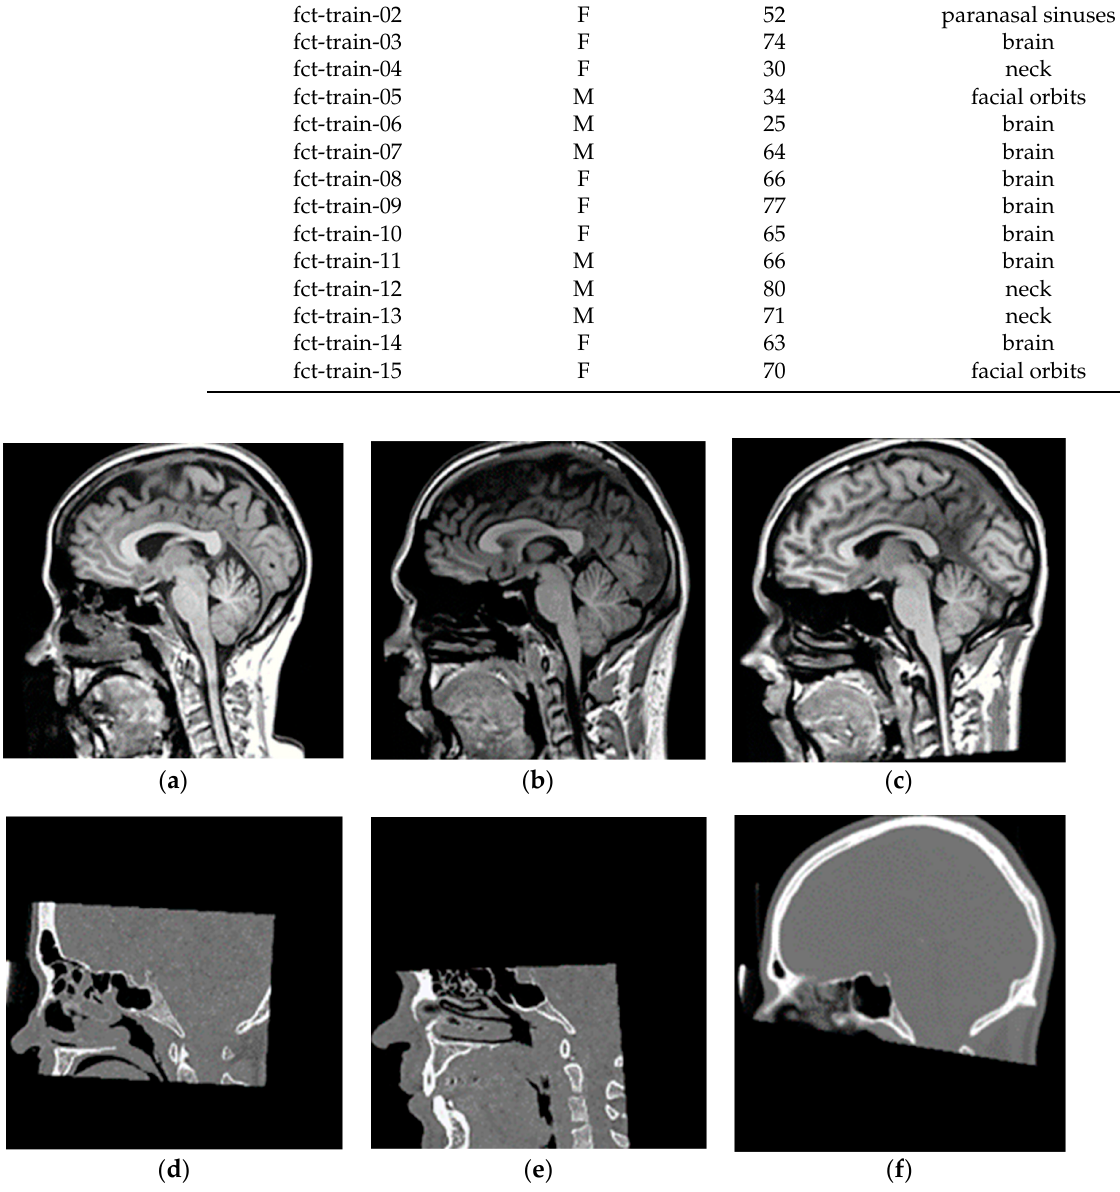
Figure 2. Representative magnetic resonance (MR)-CT pairs from the training dataset showing ( a – c ) full head and neck MRs and ( d – f ) their corresponding paranasal sinuses, facial orbits, and brain CT images, respectively.